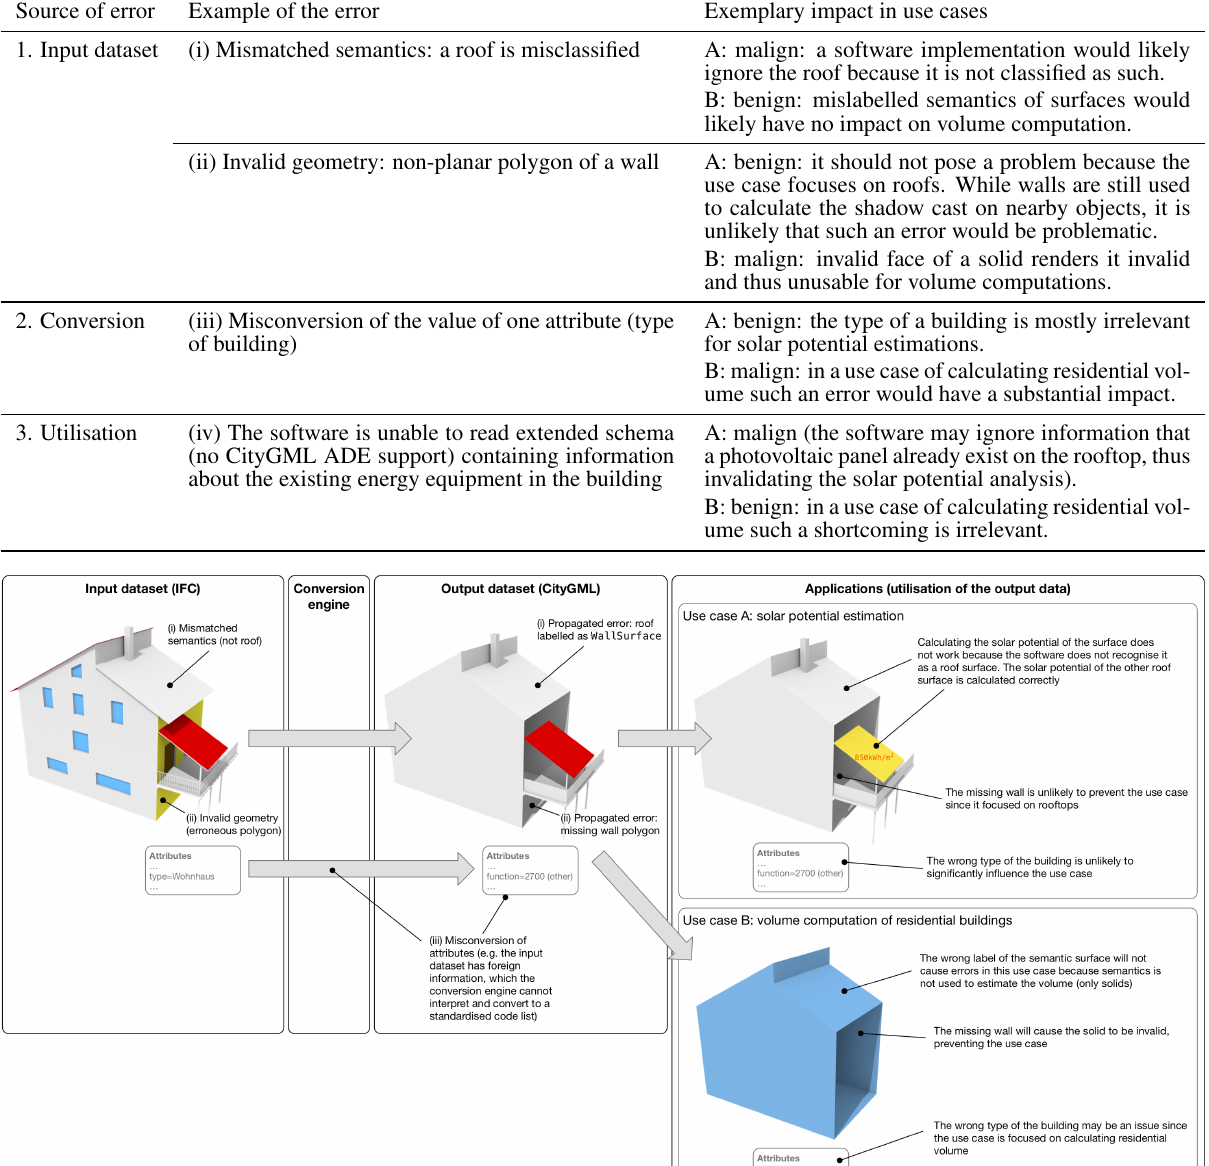
Table 1. Classification of errors from the application-dependent view. Example for (A) solar potential estimation of rooftops and (B) volume computation. The first three errors are illustrated in Figure 4. Source of error Example of the error